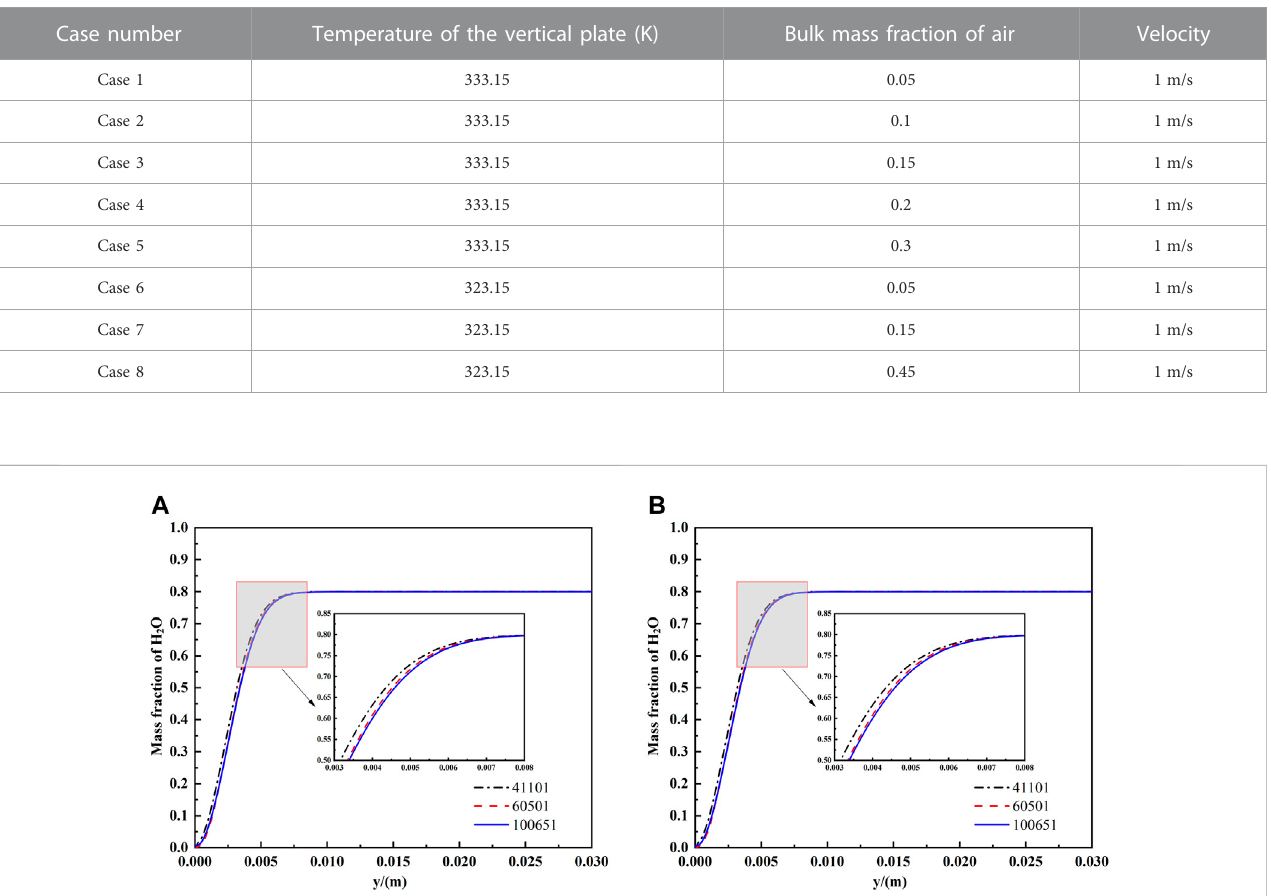
TABLE 1 Working conditions during simulation.